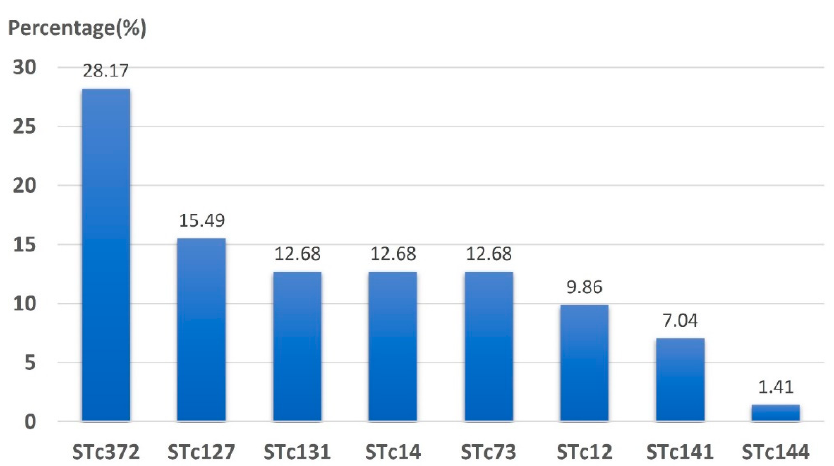
Figure 2. Sequence type, clonal complex (STc) distribution of phylogenetic group B2. Table 1. Risk factors of antimicrobial-resistant E. coli in the fecal carriage of dogs. ESBL-Producing E. coli